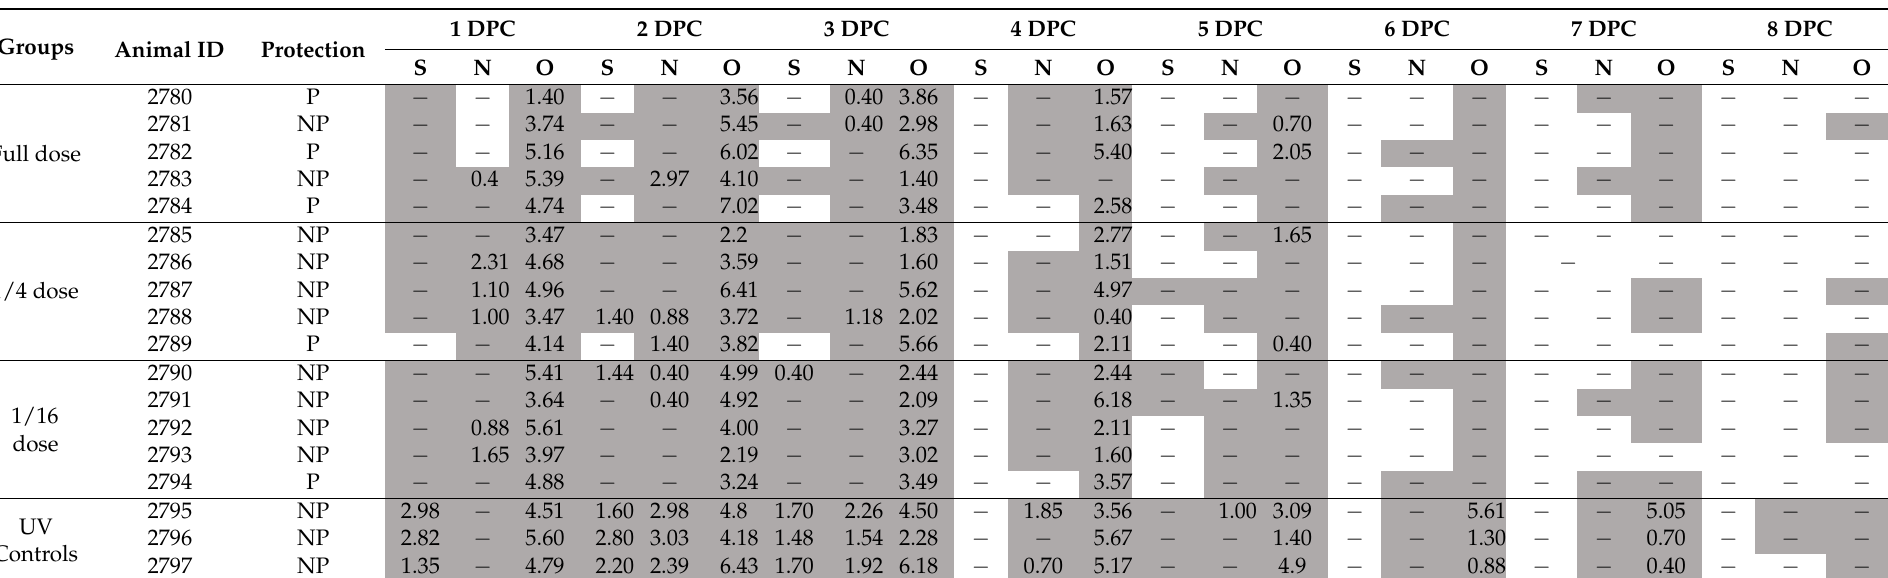
Table 2. Virus isolation and real-time PCR results from serum, nasal secretions, and oral swabs. The cattle were vaccinated either with a full dose, 1/4 dose, or 1/16 dose of A/ASIA/G-VII vaccine and were challenged 21 days after vaccination with an A/IRN/05 strain. Protection: P—protected and NP—not protected; DPC—day post-challenge; − No virus detected; samples in the grey shaded cells were positive for virus genome by real-time RT-PCR; S—serum; N—nasal